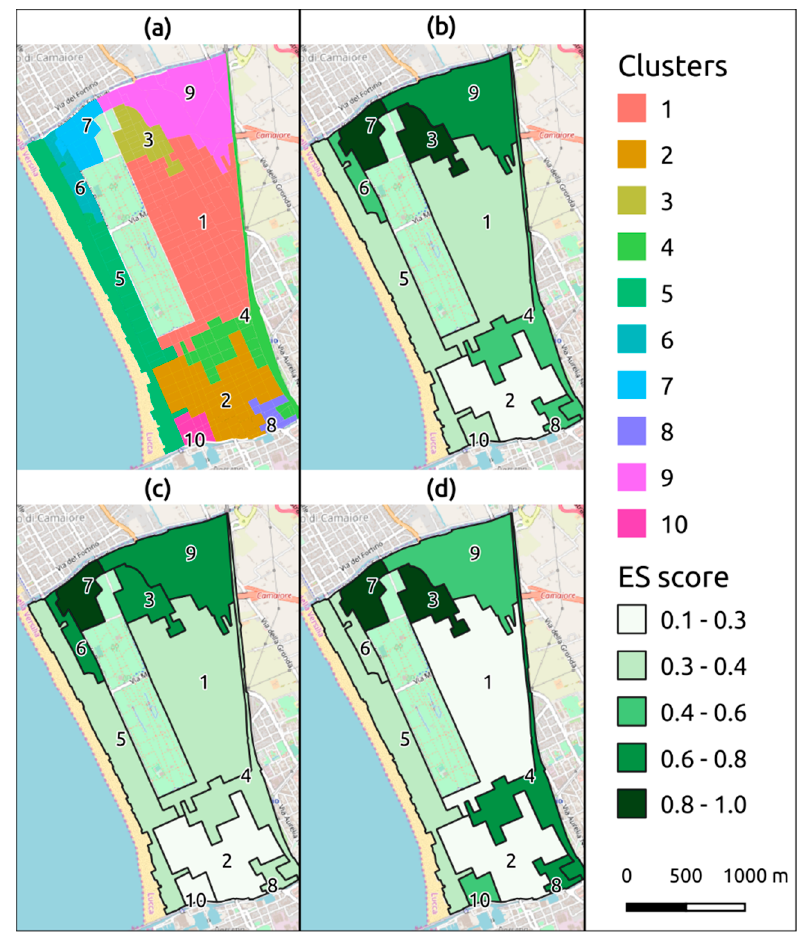
Figure 12. ( a ) Cluster map, ( b ) Ecosystem Services total score map, ( c ) Ecosystem Services score below block heights, and ( d ) Ecosystem Services score above the block height.